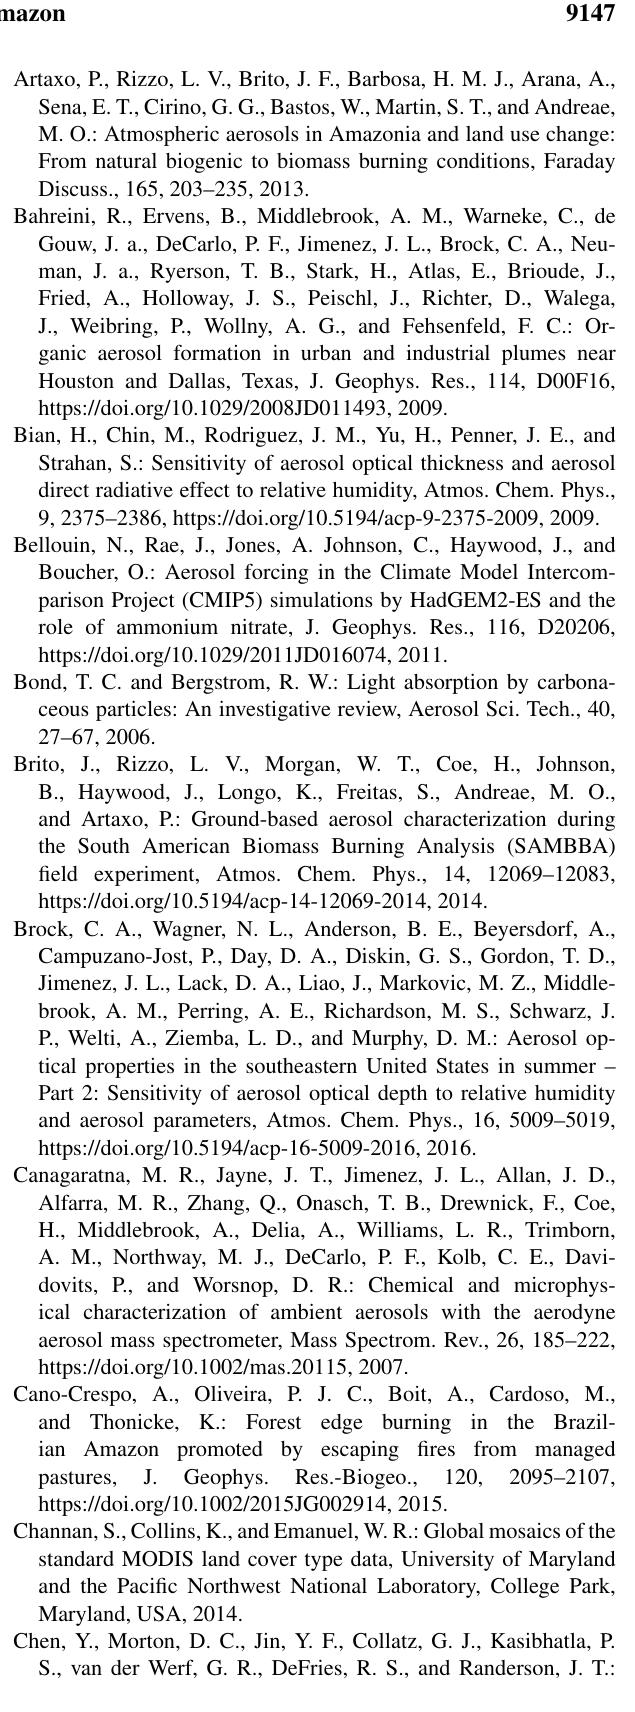
Figgans, G.: Aerosol–radiation–cloud interactions in a re- gional coupled model: the effects of convective parameteri-